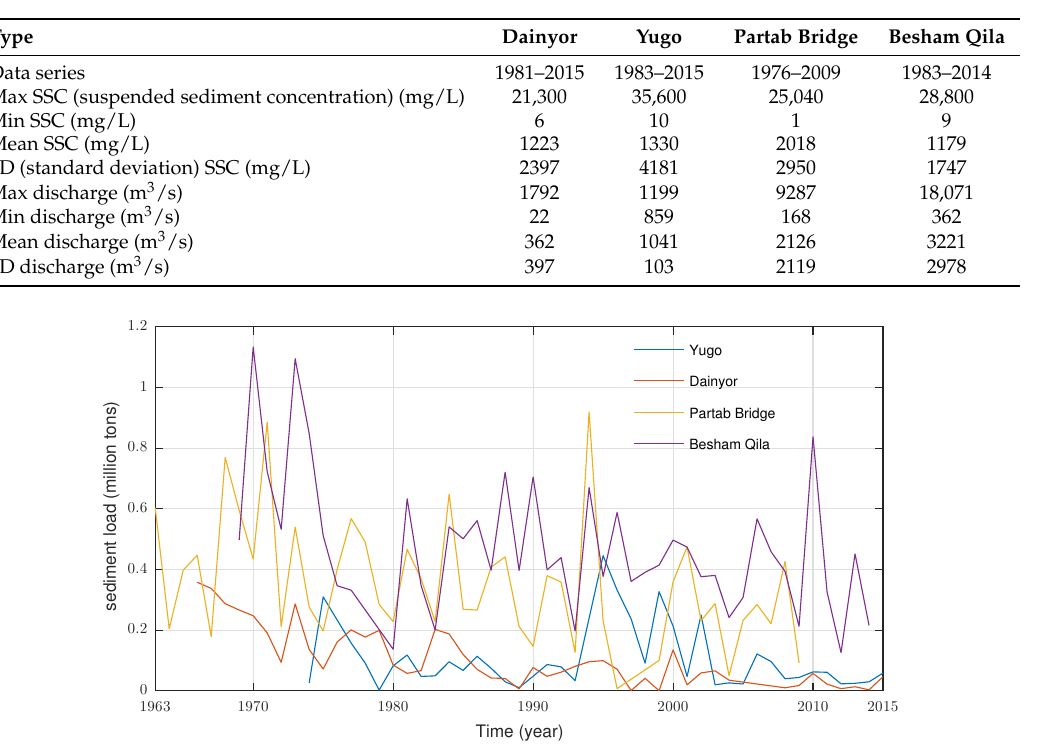
Figure 3. Mean annual suspended sediment loads (SSLs) at ( a ) Yugo, ( b ) Dainyor, ( c ) Partab, and ( d ) Besham Qila stations used in the